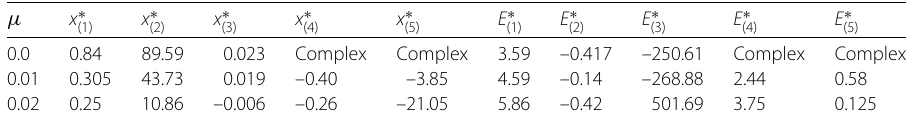
Table 3 Optimal singular solution for different discount rate